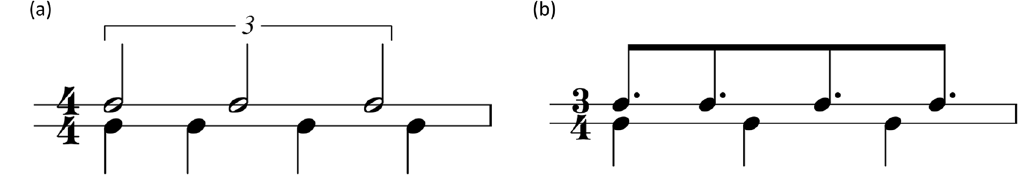
Figure 1. 3-against-4 pattern. In ( a ) the meter is 4/4 with the three-beat pattern as the counter-metric pattern. In ( b ) the meter is 3/4, with the four-beat pattern as the counter-metric